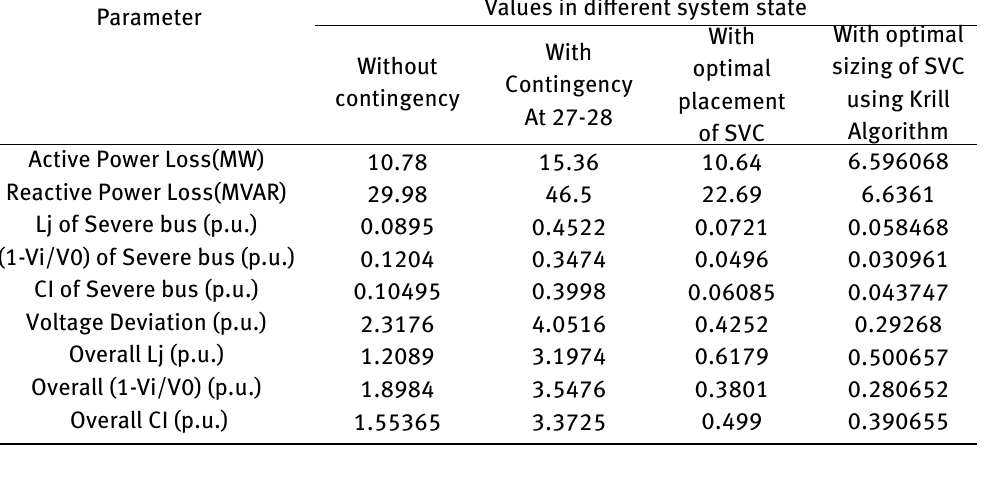
Values in different system state